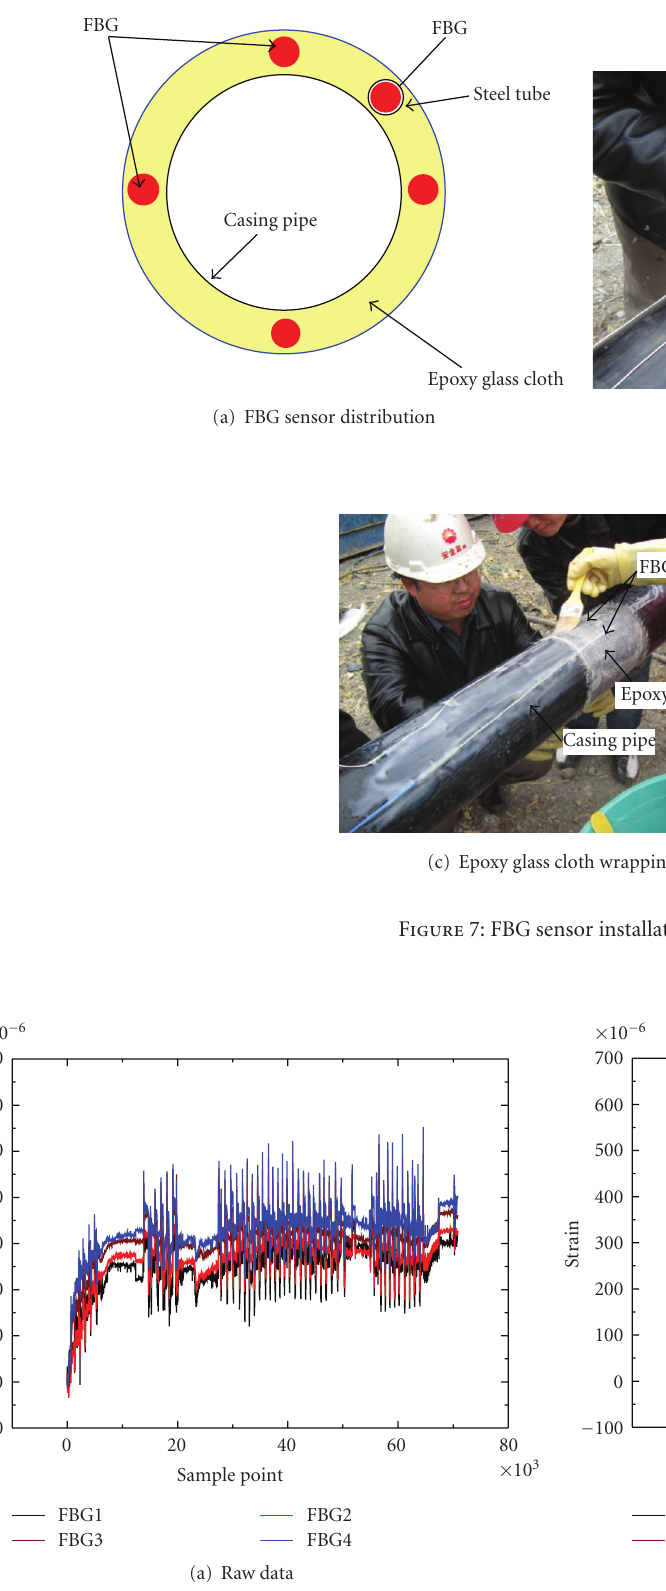
Figure 8: Strain measurements during casing of the oil